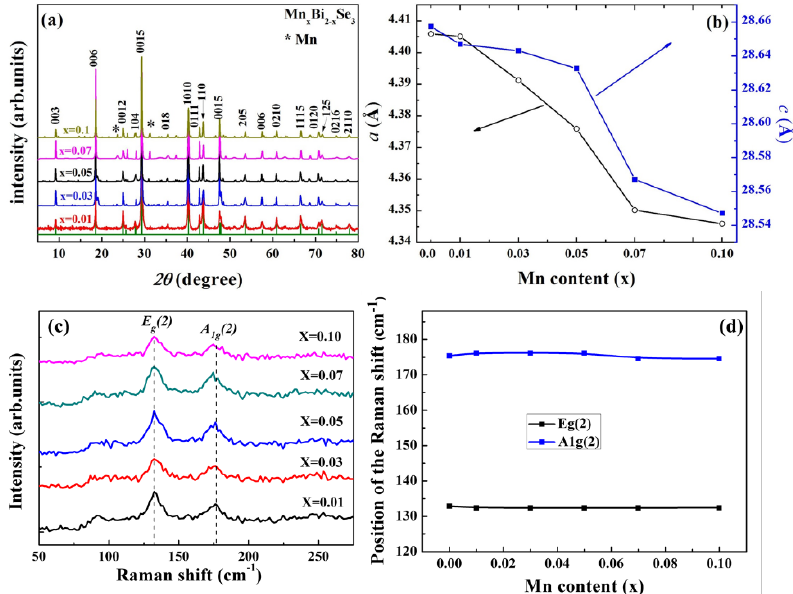
Figure 6. With different Mn concentrations: ( a ) the XRD patterns of Mn x Bi 2- x Se 3 , (“*”, it represents the position of the XRD diffraction peak of Mn); ( b ) the lattice constant a and c decreases in amount,(the blue squares represent the lattice parameters of c in the (006) direction with the different Mn doping concentrations; and the black circle represent the lattice parameters of a with the different Mn doping concentrations.); (c) the Raman spectra of the Mn x Bi 2- x Se 3 single crystals; and ( d ) the position of the Raman peaks.